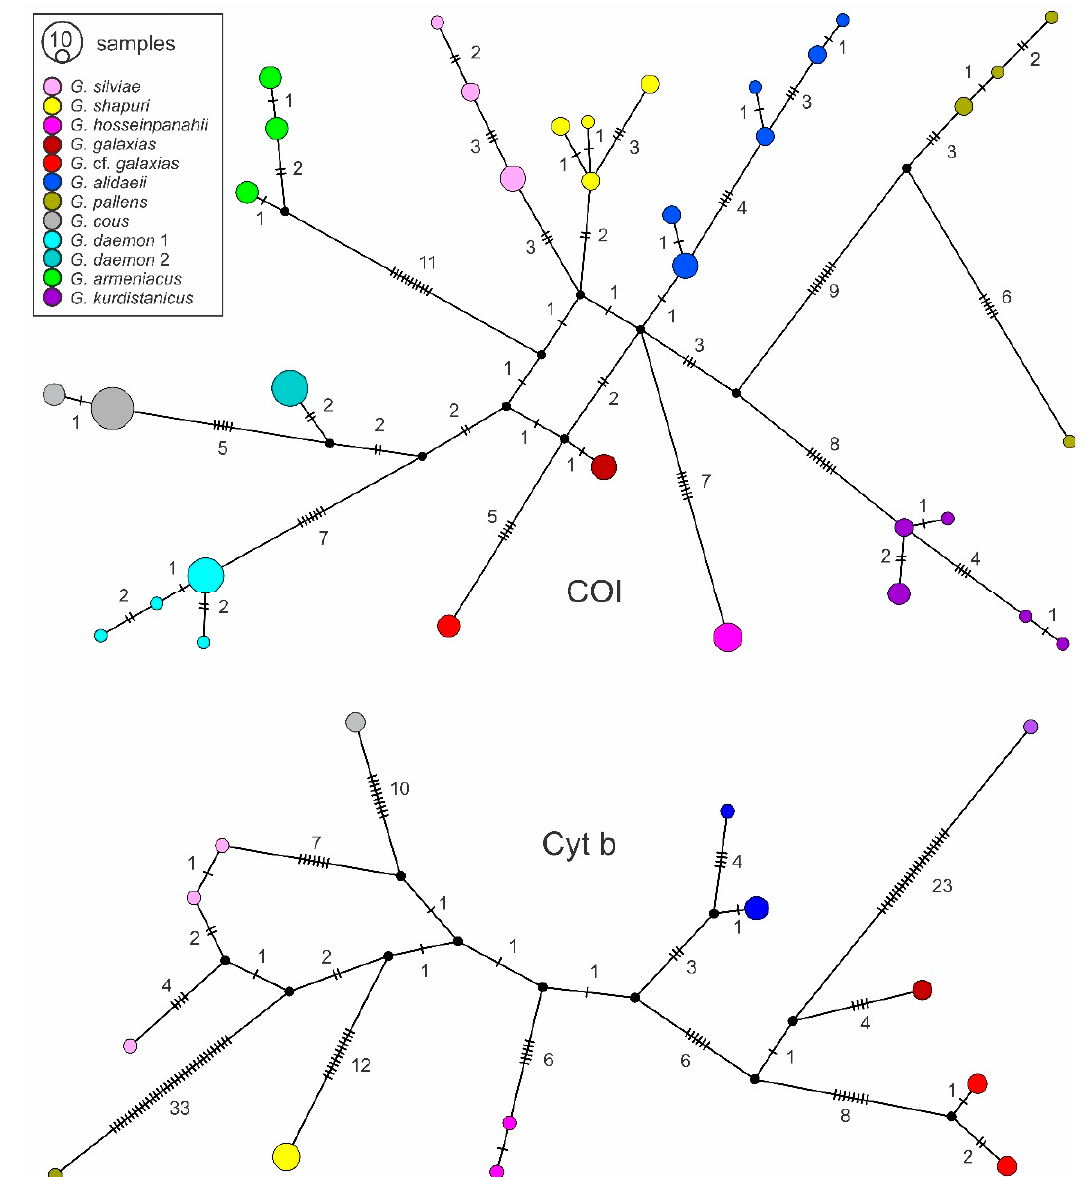
Figure 4. Median-joining (MJ) haplotype networks of mitochondrial COI and Cyt b haplotypes of Glyptothorax spp. from the Middle East. Circle sizes depict proportions of haplotypes, the smallest corresponds to one. Small black circles correspond to missing/hypothetical haplotypes. Hatch marks/numbers represent mutational steps between neighboring haplotypes.